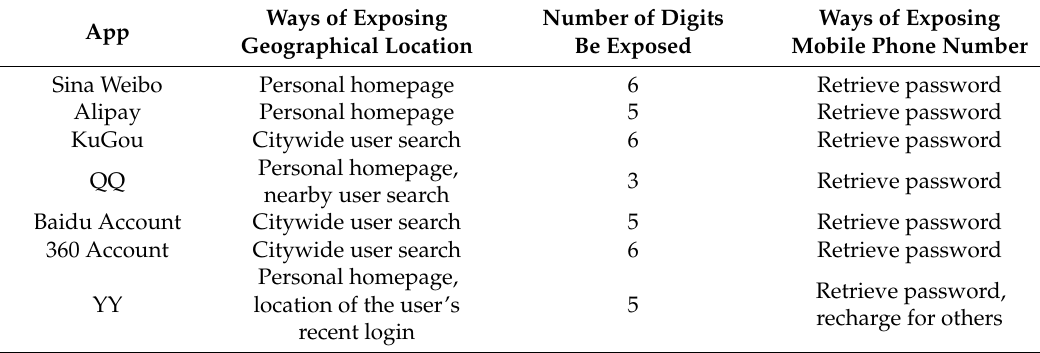
Table 1. The exposure of user’s geographical location and mobile phone number of seven apps.